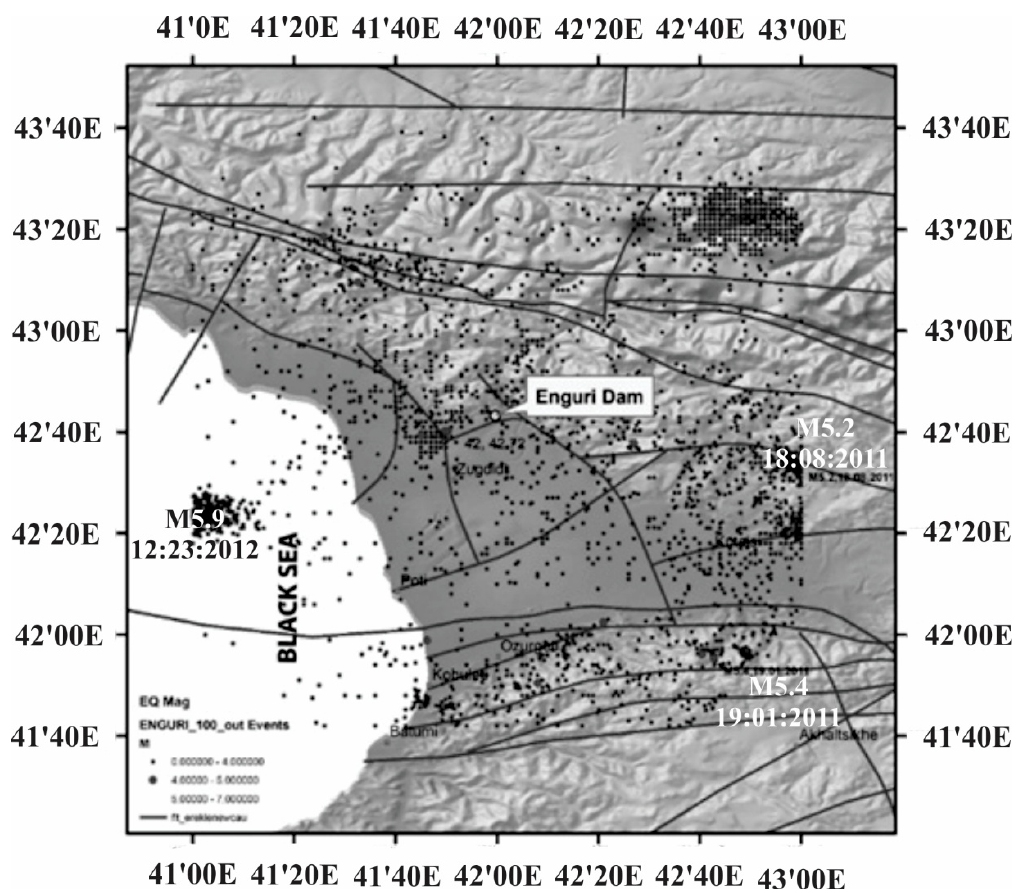
Figure 2. Seismicity of the Enguri Dam region within 100 km distance, with the scheme of active tectonic faults, according to